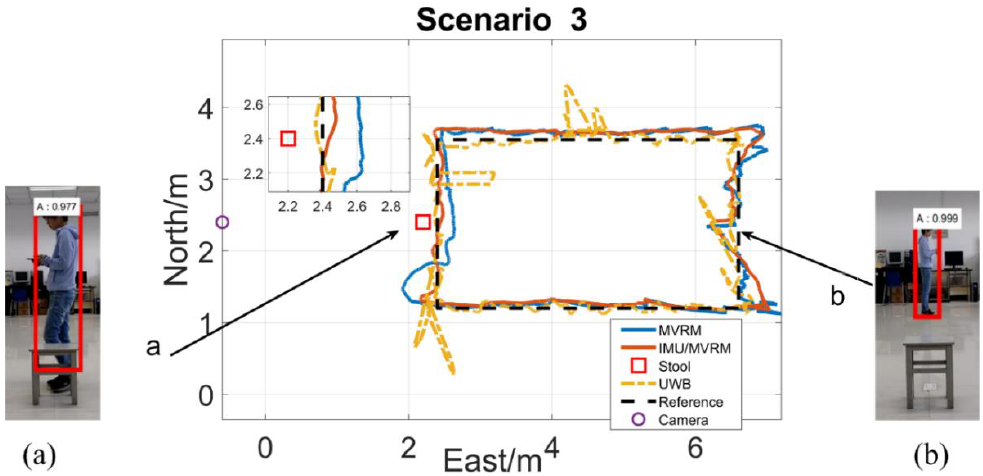
Figure 15. The horizontal trajectory in stool scenario. ( a ) the stool blocked the little view of the camera from seeing the test person at the marker 10th, succeed to detect but caused image height errors; ( b ) the stool is not able to block any view of the camera from seeing the test person near the marker 21st, succeed to precisely detect.